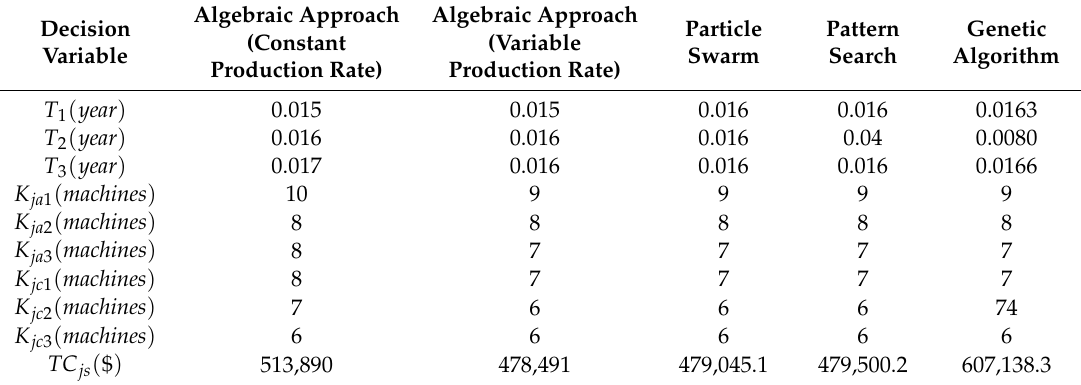
Table 4. The optimal result of the production model with solution for the processing of sugar.